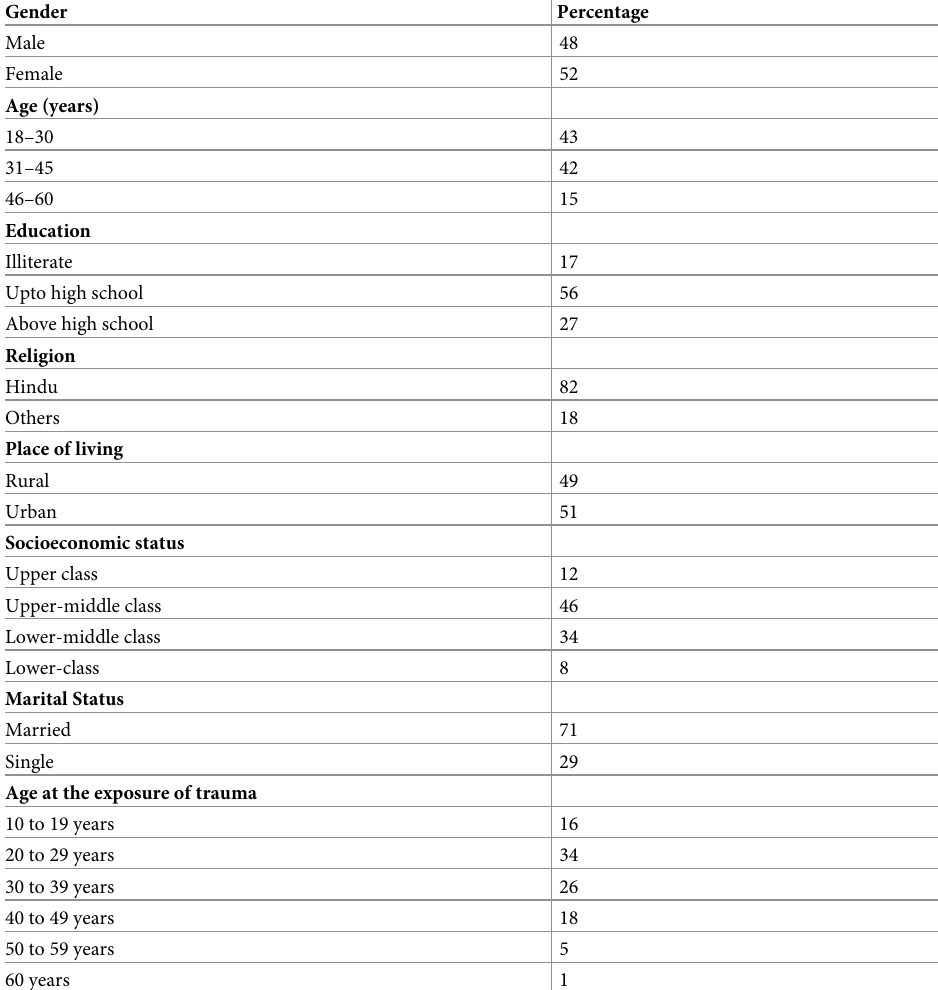
Table 1. Sociodemographic